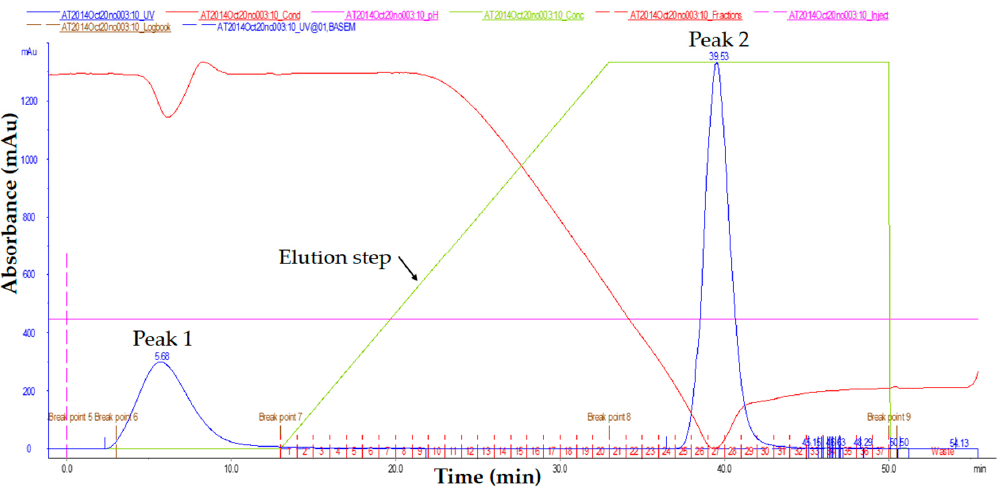
Figure 2. Chromatogram of IgG elution from nProtein A Sepharose affinity column using AKTAprime protein purifier system.